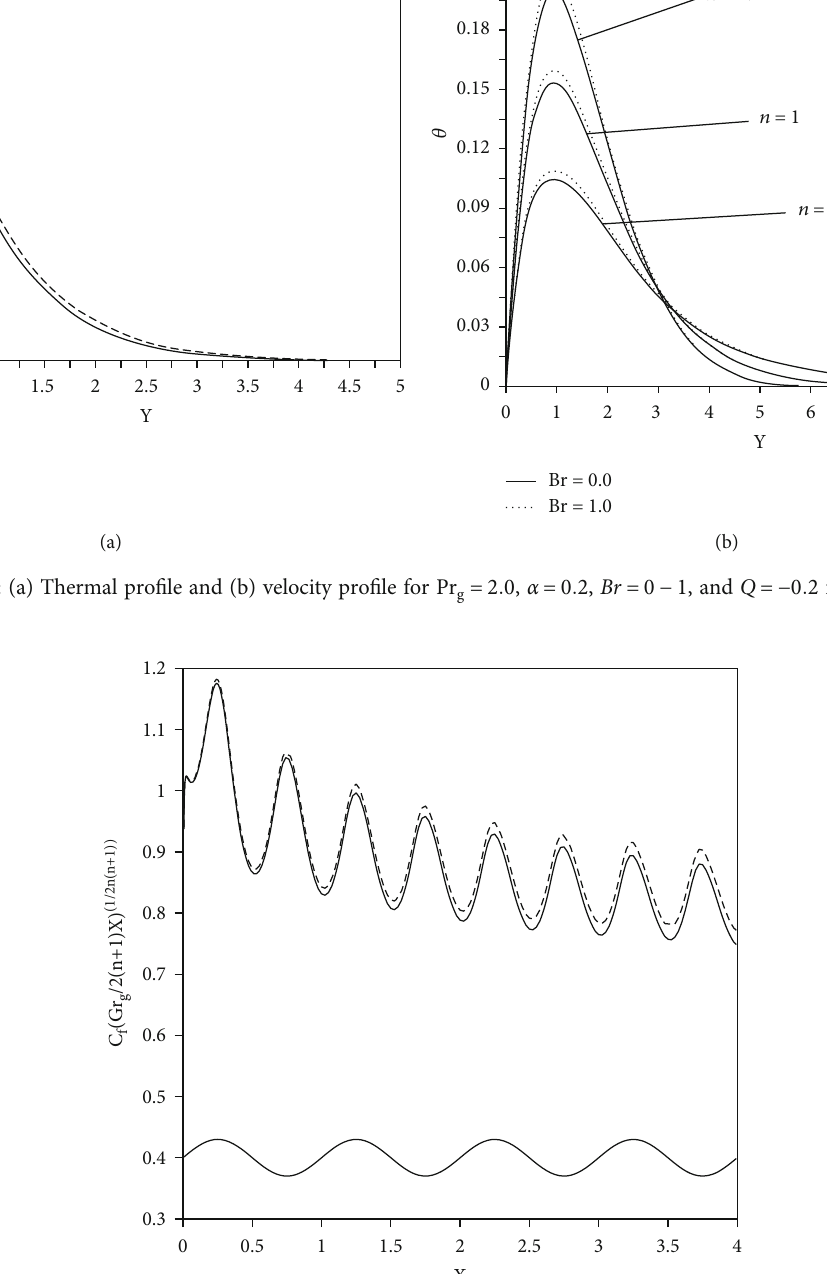
= 2 , α = 0 : 2 , Br = 0 -1, n = 0 : 8 , and Q = − 0 : 2 g